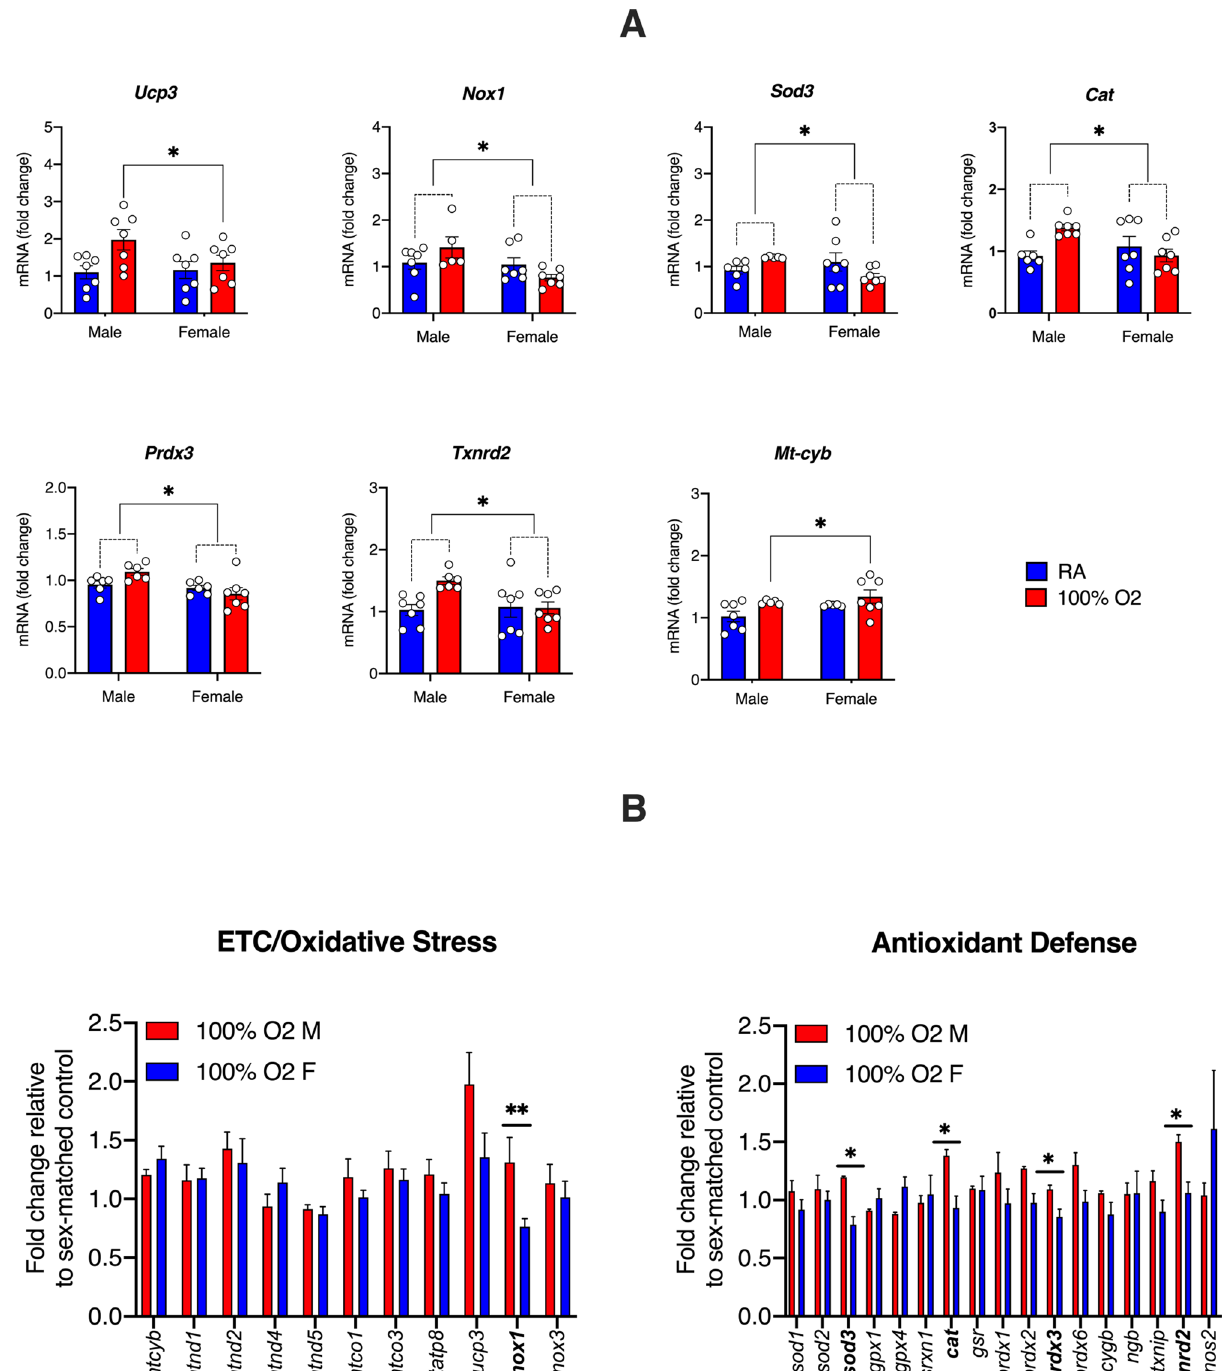
Figure 3. Differentially expressed oxidative stress genes in the fetal brain after maternal hyperoxia. ( A ) Scatter plots showing differential expression of genes involved in the oxidative stress response and prevention after maternal hyperoxia. There was a significant effect of treatment for Ucp3 ([F (1, 24) = 5.7]) and Mt-cyb ([F (1, 20) = 5.06]), and a significant treatment vs . sex interaction for Nox1 ([F (1, 22) = 4.32]), Sod3 ([F (1, 21) = 5.5]), Cat ([F (1, 23) = 7.79]), Prdx3 ([F (1, 21) = 4.46]), and Txnrd2 ([F (1, 23) = 4.76]). ( B ) Bar graphs highlighting the sex-dependent differences in gene expression involving oxidative stress ( left ) and antioxidant defense ( right ) after maternal hyperoxia with 100% oxygen (ETC: electron transport chain). Data are presented as mean ± S.E.M and analyzed with 2-way ANOVA with Sidak’s multiple comparisons test to assess for sex differences in the treated group; *p ≤ 0.05 and **p ≤ 0.01 (n = 7 male and female pups from 7 unique dams/treatment